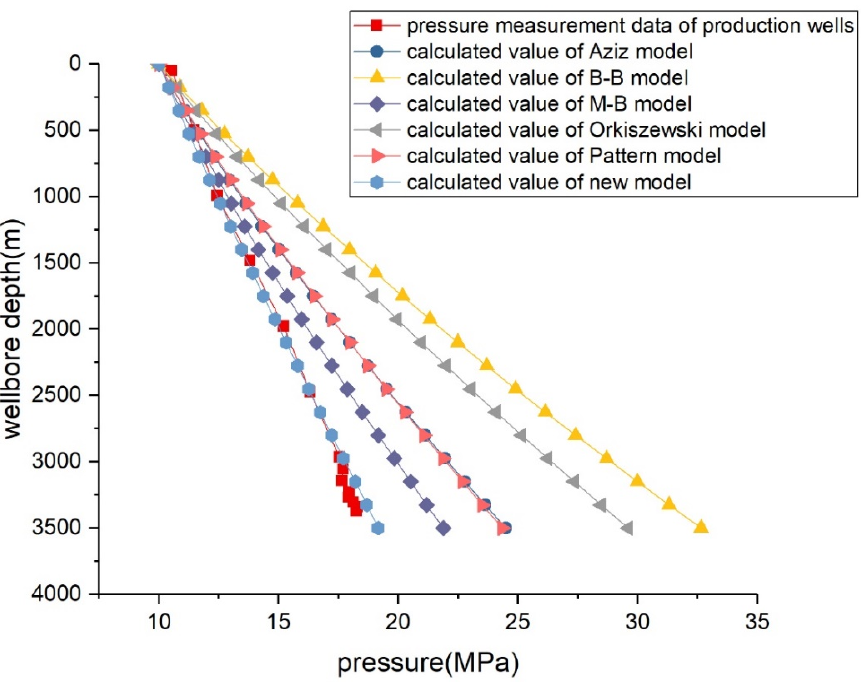
Figure 21. Different pressure calculation methods applied to the No. 1 well of the Donghai gas field.